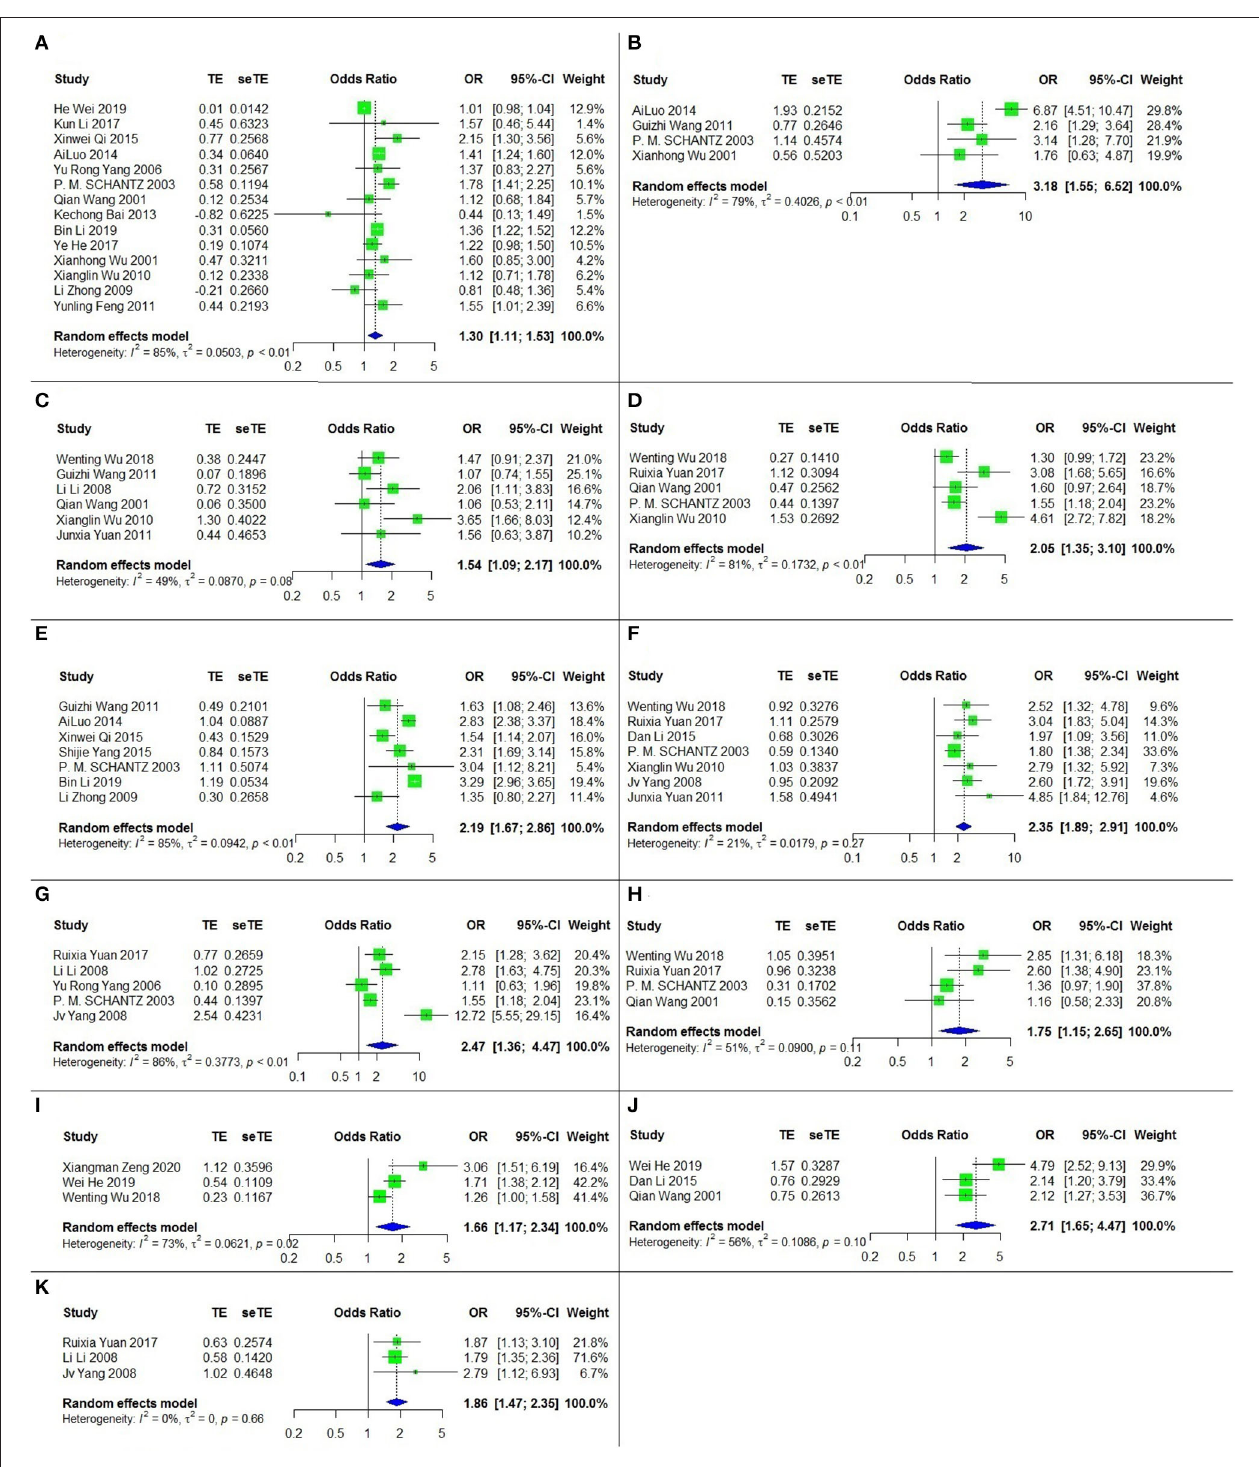
FIGURE 4 | The forest chart of CE factors. (A) Sex (female/male); (B) Ethnicity (Tibetan/Han); (C) Dog ownership; (D) Not washing hands before meals; (E) Herdsman occupation; (F) Feeding viscera to dogs; (G) Drinking nonboiled water; (H) Presence of stray dogs; (I) Number of household dog (with each addition); (J) Nomadism; (K) Eating raw